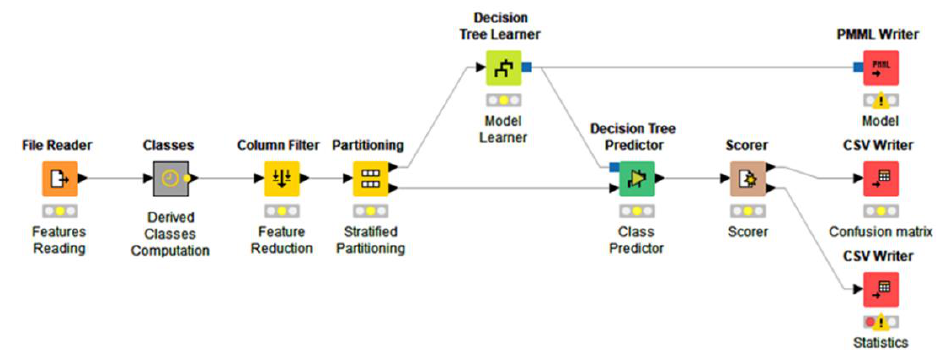
Figure 10. Knime workflow.